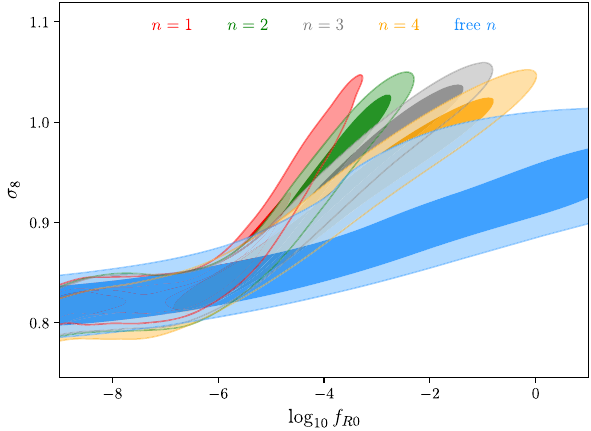
( R ) models with n = 1